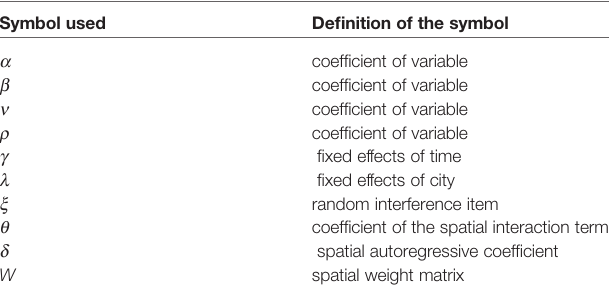
TABLE 10 | Nomenclatures.